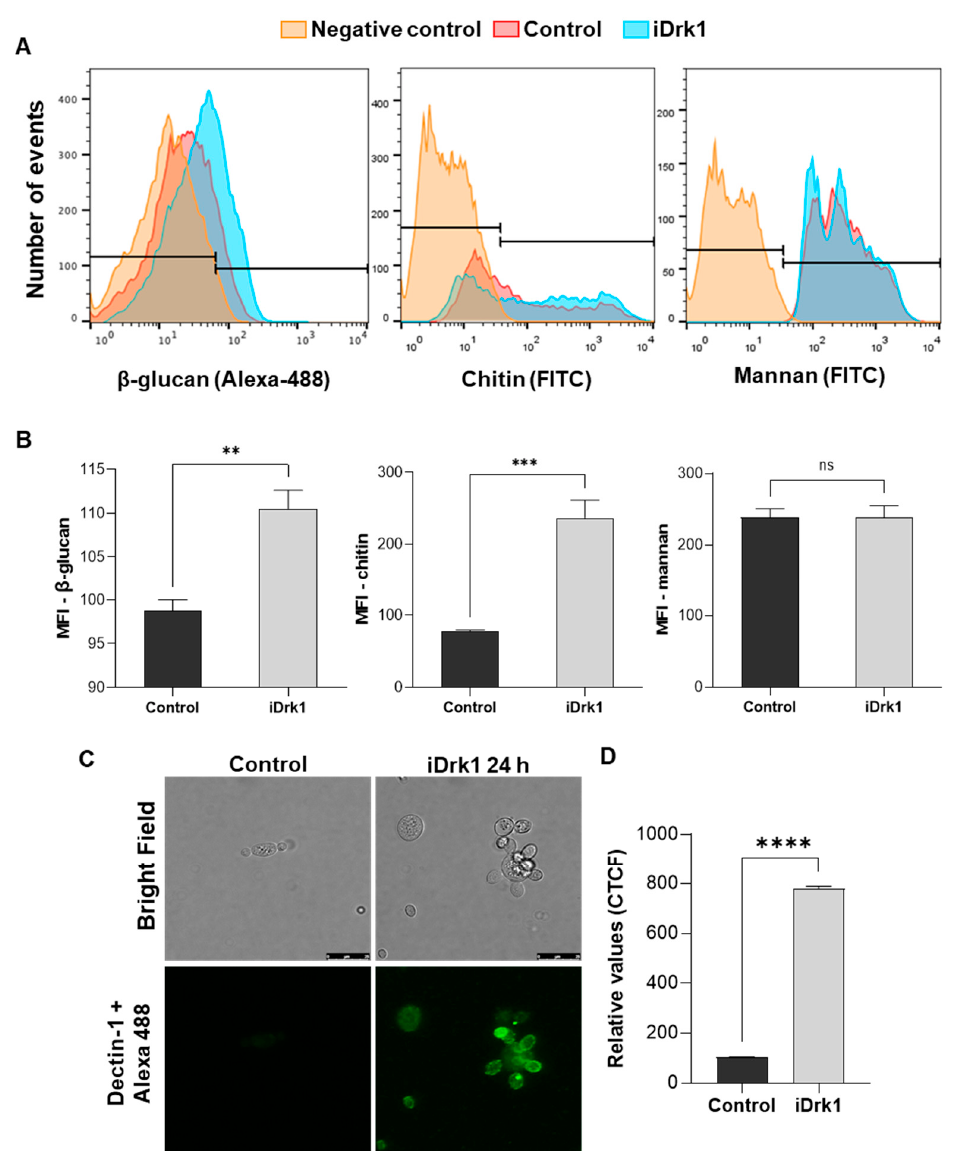
Figure 3. Quantification of P. brasiliensis cell wall components after incubation with iDrk1. Pb 18 cells were subjected to 25 µg/mL of iDrk1 for 24 h and then labeled with fc-Dectin-1 and Alexa 488 for dosage of β -glucan, WSA conjugated with FITC for dosage of chitin oligomers and Concanavalin A conjugated with FITC for mannan dosage. ( A ) Histograms from each cell wall component by flow cytometry, where negative control is represented as yeast that were not fluorescence labelled. ( B ) Quantification through the median fluorescence intensity (MFI) where p -value ≤ 0.004 (**). Evaluation of β - glucan exposure in P. brasiliensis cell wall after incubation with iDrk1. Cells of Pb18 were subjected to 25 µg/mL of iDrk1 for 24 h and then labeled with fc-Dectin-1 and Alexa 488. ( C ) Confocal microscopy analysis. ( D ) Corrected quantification of total fluorescence (CTCF) from confocal microscopy analysis where p -value ≤ 0.01 (**), p -value ≤ 0.001 (***) and p -value ≤ 0.0001 (****).